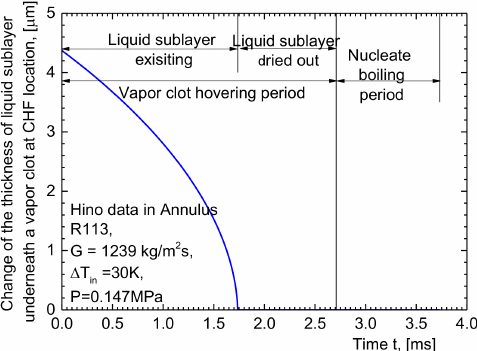
Figure 8. Calculated liquid sublayer thickness change at the channel exit (CHF point).